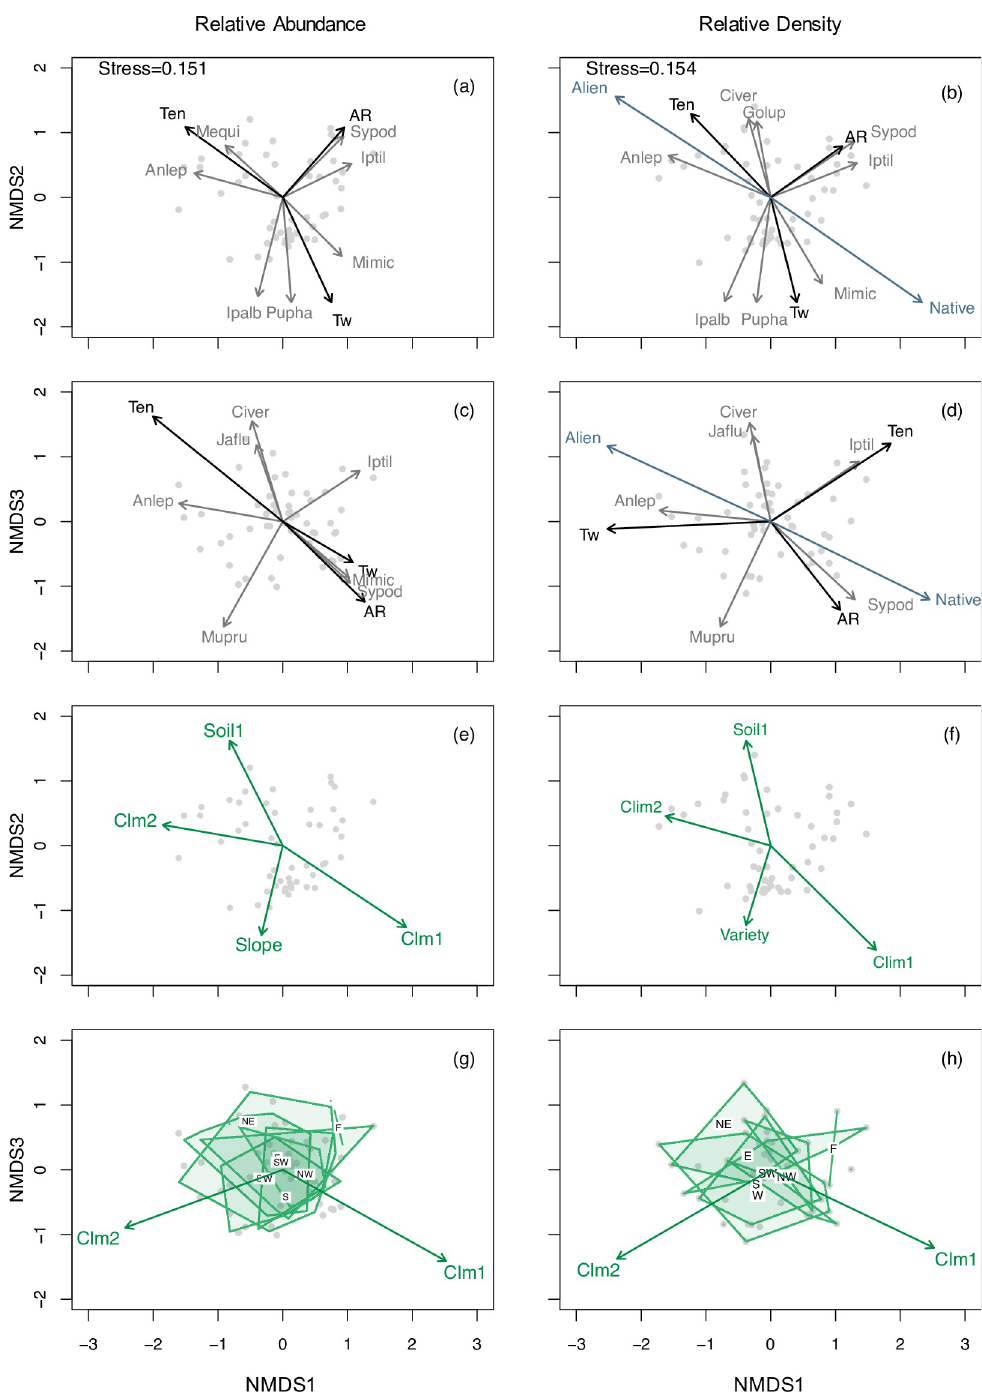
Fig 4. Non-metric multidimensional scaling-NMDS ordination of vine patches based on species’ relative abundance ; a, c, e, g) and relative density ( D ; b, d, f, h). A secondary matrix of abiotic and biotic variables is based on medium- ( A s s scale (270 m 2 ) spatial data. In a-d species are represented by grey and functional groups by black vectors; only species and functional groups significantly correlated ( α = 0.001 and 0.05, respectively) with the ordination axes are shown. In e-h abiotic variables are represented by green vectors or polygons (categorical; aspect); only the variables that were significantly correlated with the ordination’s axes are shown ( α = 0.05). Gray dots are vine patches. The species codes are provided in Table C in S1 File. Functional groups: Te; Tendrils, Tw; Twining, Sc; Scandent/Sarmentous, AR; Aerial roots. Aspect: F; Flat, NE; Northeast, E; East, SE; Southeast, S; South, SW; Southwest, W; West, NW; Northwest.